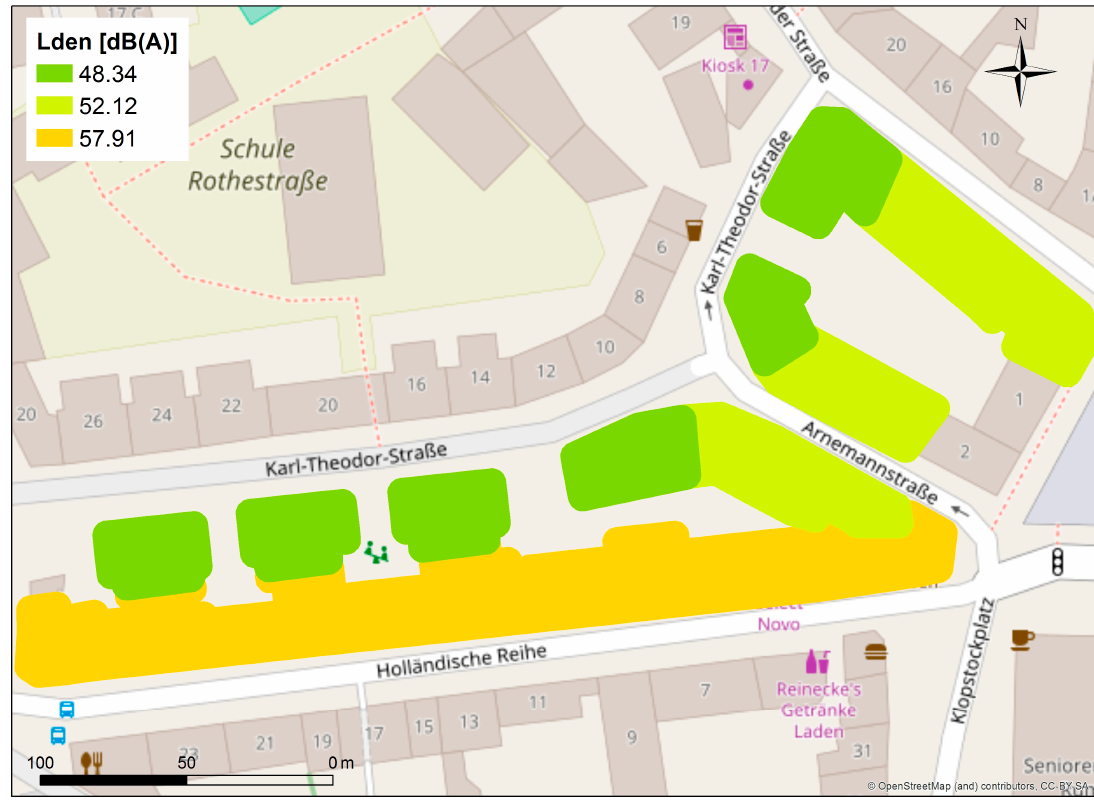
Figure 4. Mean noise levels with a 3 meter buffer in survey area 6. Table 3. Noise variables (data L den and L night